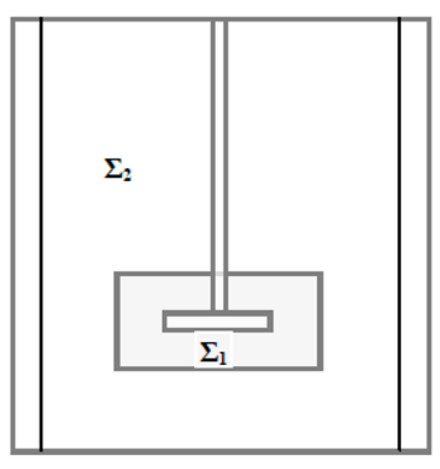
Figure 2. Cylindrical tank with an MRF boundary surrounding the impeller.